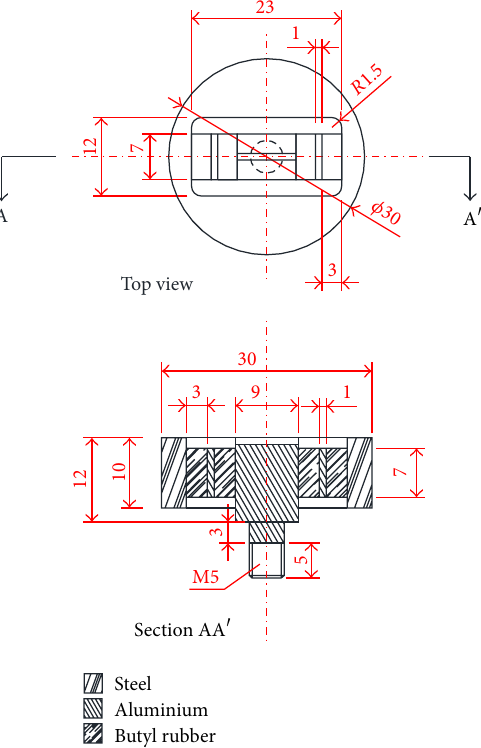
Figure 7: VDVN drawings (all dimensions are in millimeters).